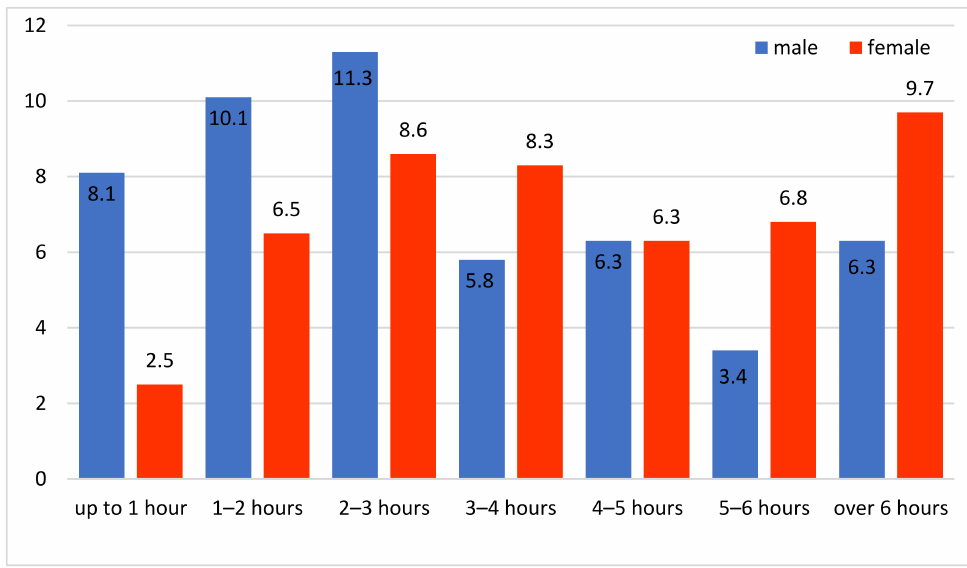
Figure 4. Time spent on social networks depending on sex (%).